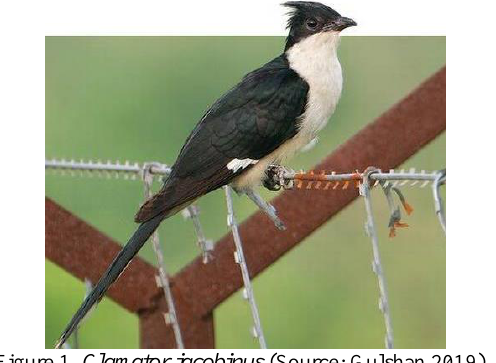
Figure 1. Clamator jacobinus (Source: Gulshan 2019)